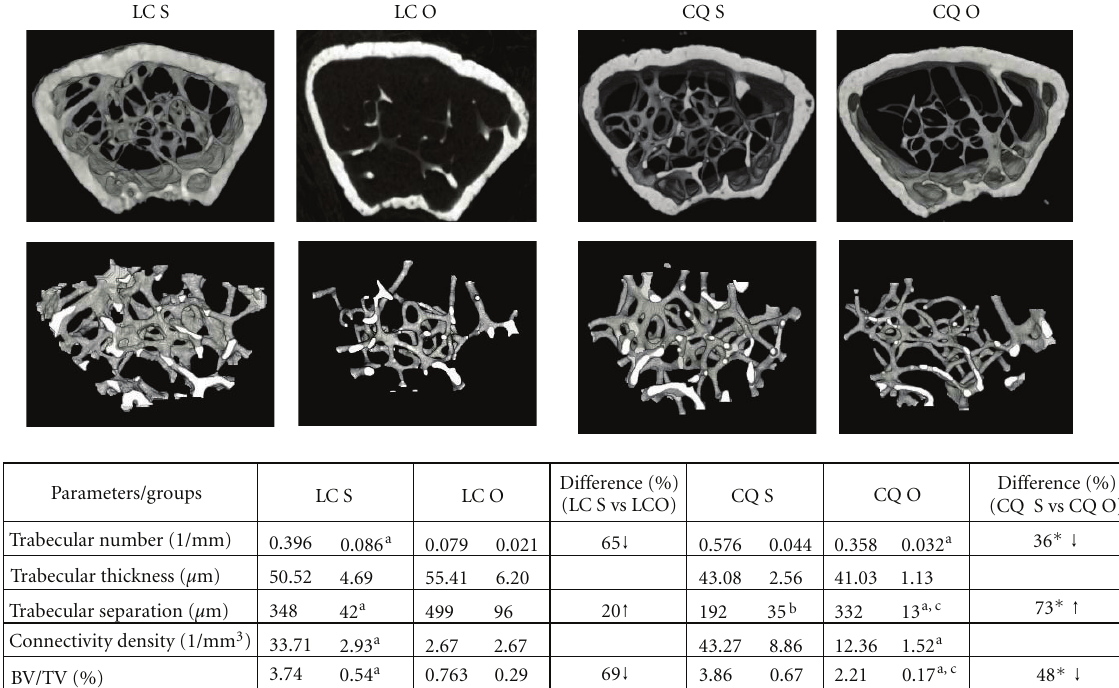
Figure 5: E ff ects of Cissus quadrangularis on the static histomorphometry parameters of the distal femoral metaphysis of C57Bl/6 mice after ovariectomy using CT. Data are Mean ± SE. LC S: lab chow sham; LC O:lab chow ovariectomy; CQ S: Cissus quadrangularis sham; CQ O: Cissus quadrangularis ovariectomy. a P < 0 . 05 versus LC O; b P < 0 . 05 versus LC S; c P < 0 . 05 versus CQ S, ∗ P < 0 . 05 versus LC. The figures are representative of the mean values that were